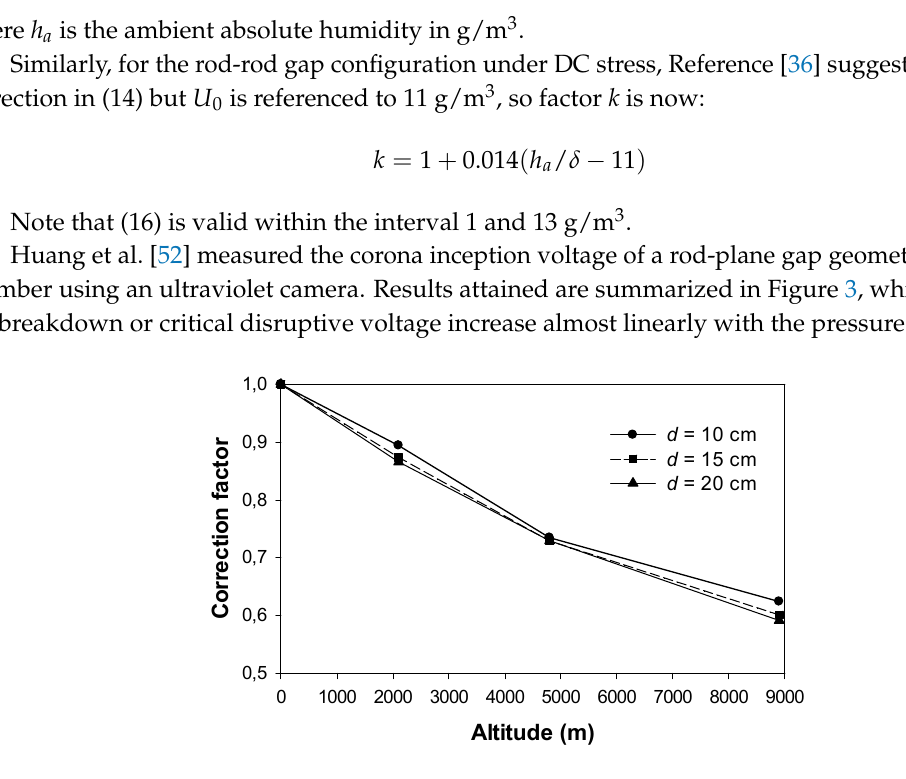
Figure 3. Rod-plane gap geometry adapted from Reference [52] by applying the hypsometric equation. Correction factor for the corona inception voltage as a function of the altitude for different gap lengths d at 25 °C and 16 g/m 3 .